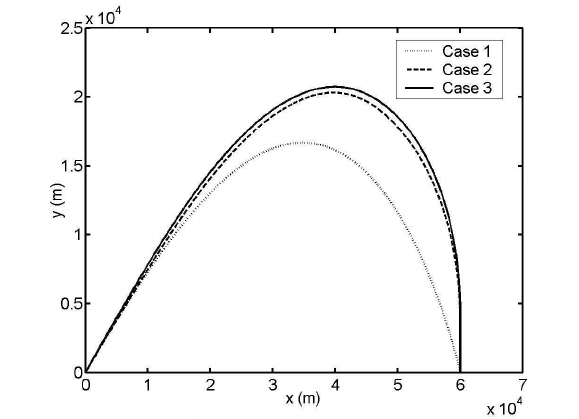
Fig. 2. Trajectories for diffirent cases.